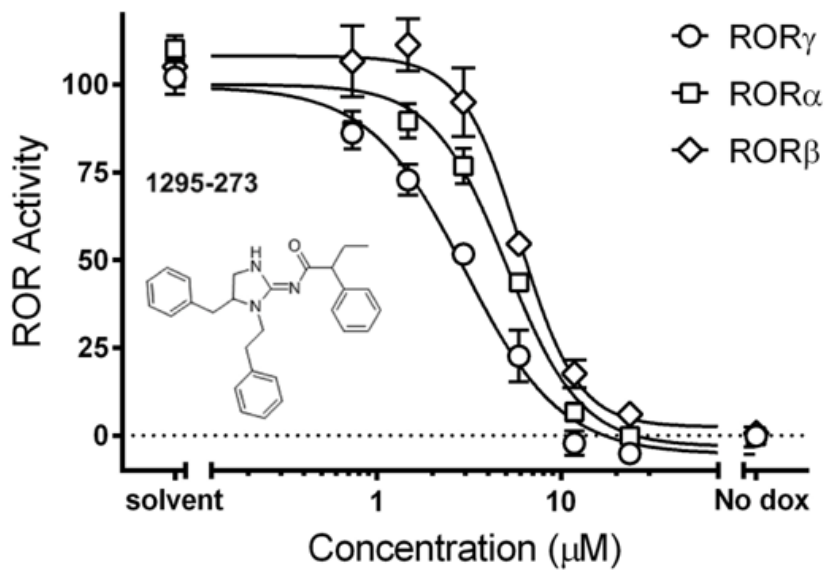
Figure 3. Dose response of compound 1295-273 in ROR cells. TRex-CHO-ROR γ / α / β cells were incubated with the indicated concentrations of 1295-273 for 20 h, when cell viability and luciferase activity were determined as indicated in materials and methods. The percentage of normalized activity (luciferase/fluorescence) for each cell line is shown. The experiment was repeated twice with quadruplicate data points and the results of one typical experiment are shown.